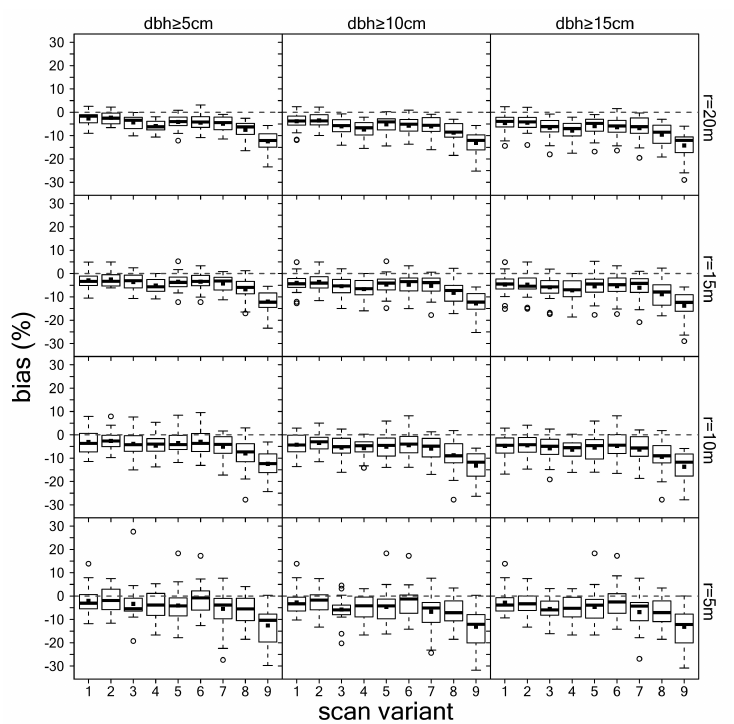
Figure A4. dbh bias in % for di ff erent scan variants, lower dbh thresholds, and plot radii. Black squares represent mean dbh